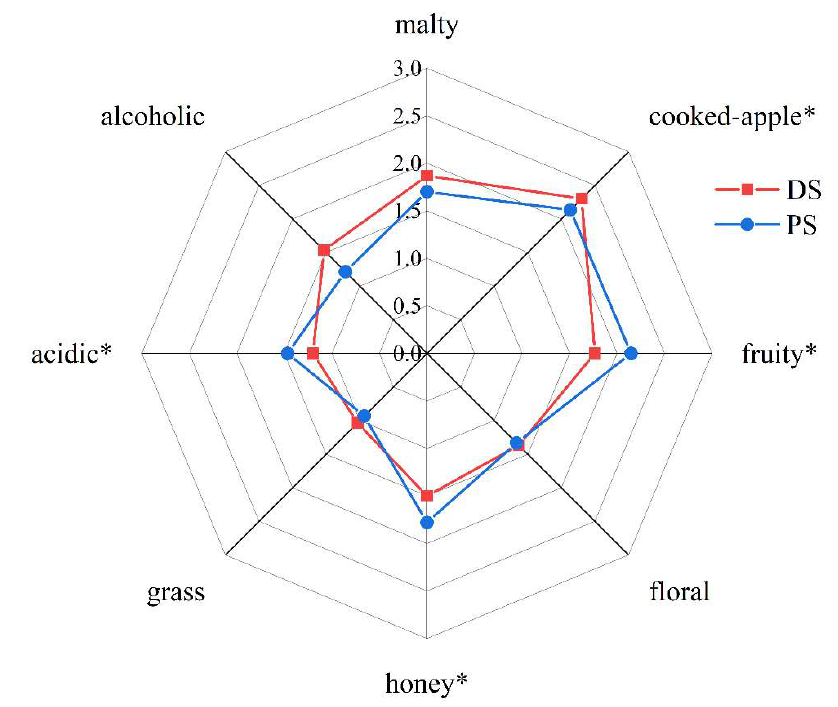
Figure 2. Comparison of aroma profiles of DS and PS. Significance: * p < 0.05.